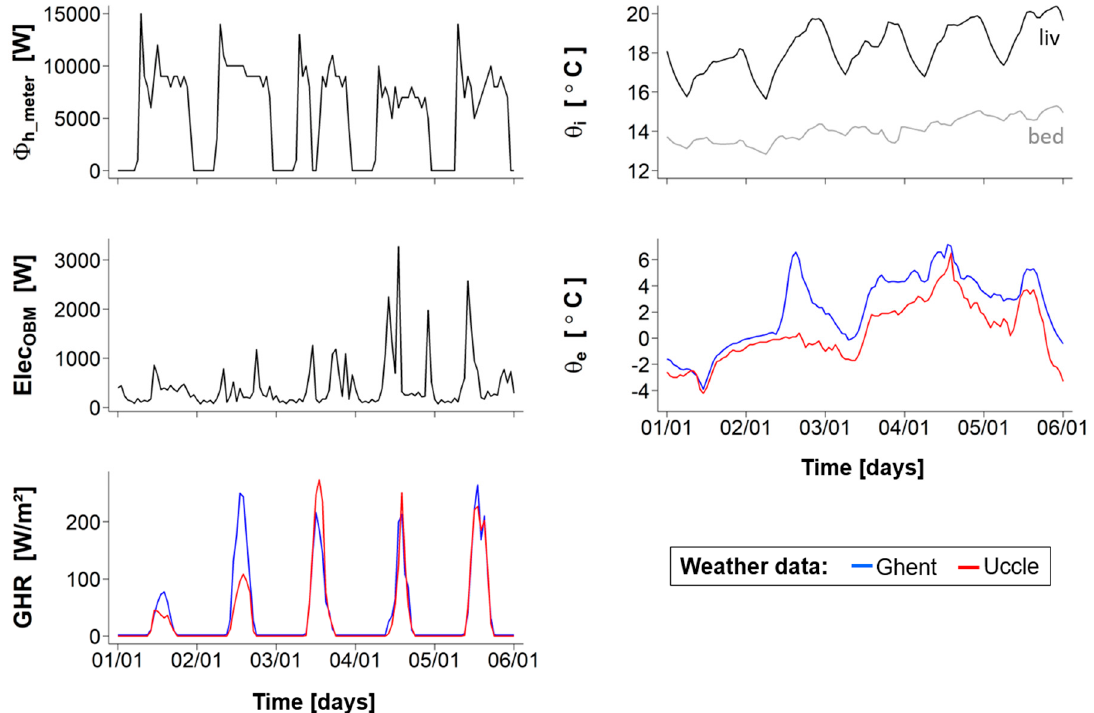
Figure 4. Time series plots of the collected monitoring data for five typical days at the beginning of January 2017. The abbreviations ‘liv’ and ‘bed’ stand for, respectively, the ‘living room’ (No. 3 in Figure 2) and the master ‘bedroom’ (No. 9 in Figure 2). Figures display hourly values.